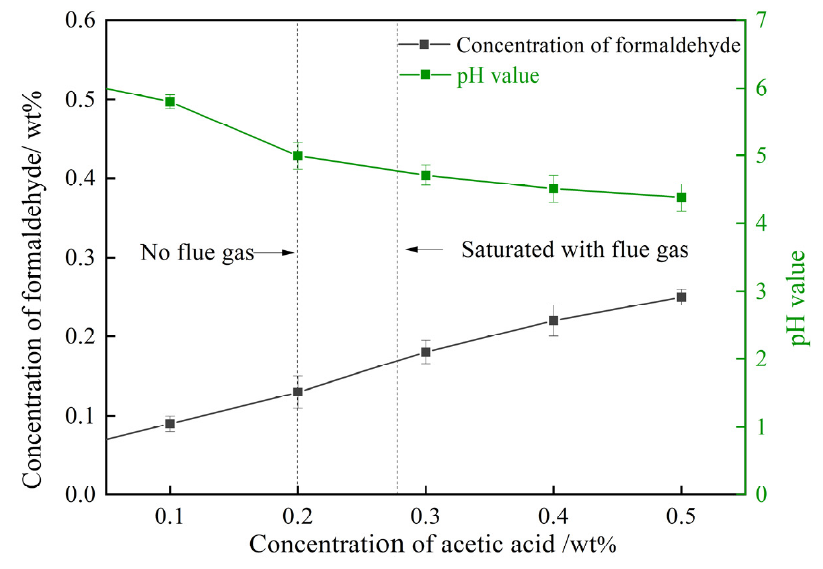
Figure 9. Effect of acetic acid on the decomposition of HMTA.